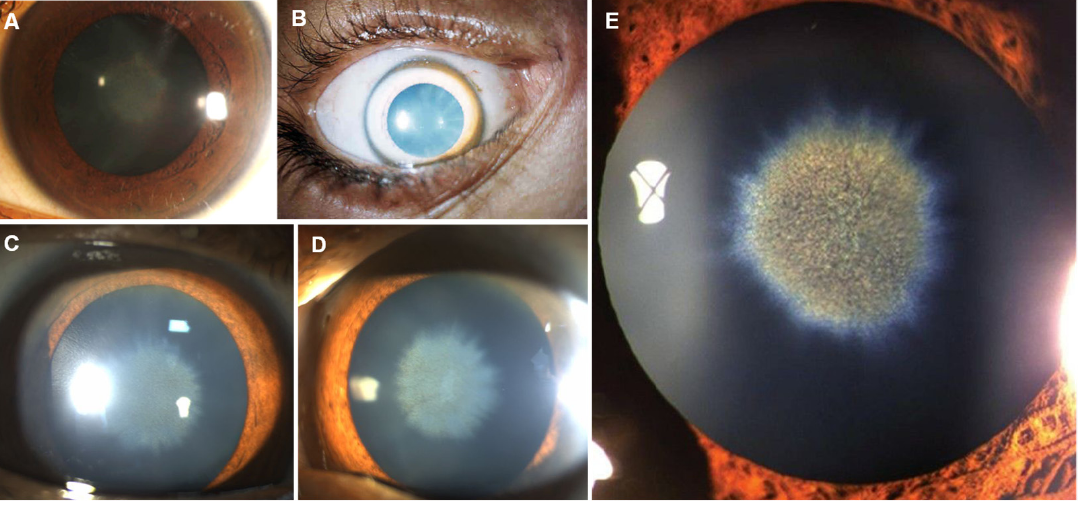
Figure 6. Sunflower cataracts seen with slit lamp—( A – E ). Reprinted from ( A )—[168], ( B )—[169], ( C , D )—[170], ( E )—[171].